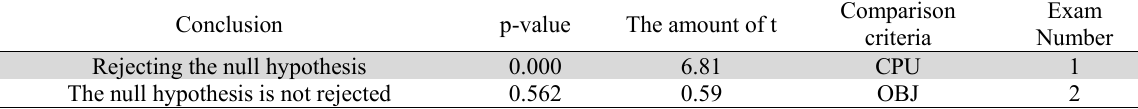
The results achieved by the algorithm criteria of SA and GA